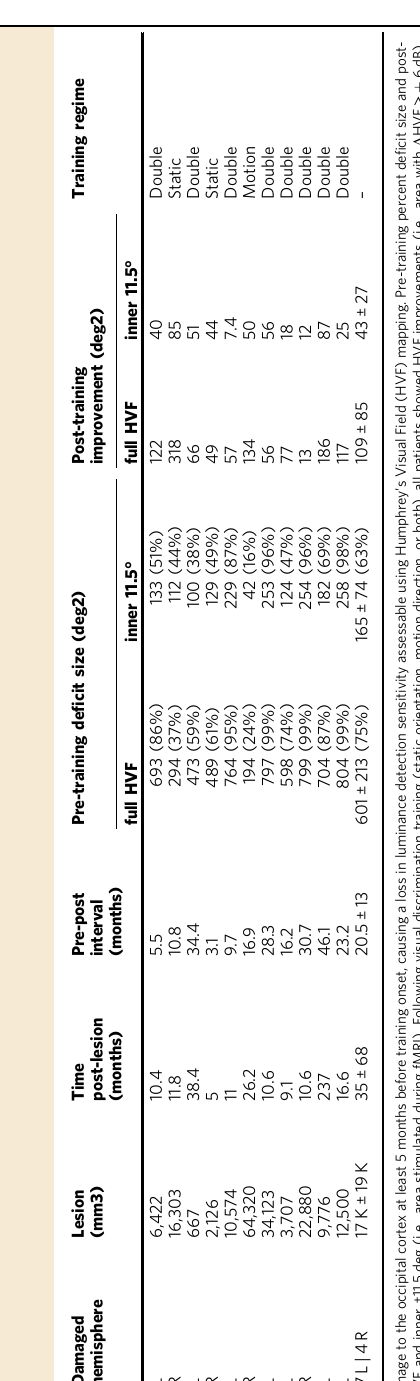
region may possess enhanced plastic potential 21